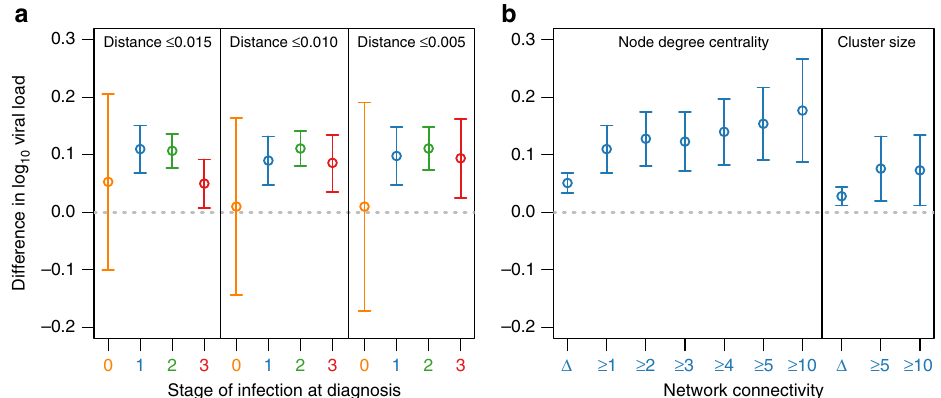
Fig. 2 Increase in viral load for clustered versus nonclustered individuals. a Betas from the multivariate regression model for the difference in log 10 viral load (copies/ml) in clustered individuals versus nonclustered at different stages of infection at diagnosis and different genetic distance thresholds: ≤ 0.015 substitutions/site, ≤ 0.010 substitutions/site, and ≤ 0.005 substitutions/site. Stage of infection is denoted by color. b Betas from the multivariate regression model for difference in log 10 viral load for individuals diagnosed at stage 1 infection with increasing node degree centrality (i.e., number of genetically linked partners) and cluster size relative to nonclustered individuals. Error bars represent the 95% con fi dence intervals for these estimates of beta. Node degree centrality compares individuals with at least that degree versus nonclustered individuals. Hence, node degree ≥ 1 in b is equivalent to clustered versus nonclustered depicted in a . Cluster size compares individuals in clusters of at least that size versus individuals in clusters of small sizes (i.e., cluster size ≥ 5 versus cluster size <5). Δ denotes the difference in log 10 viral load for each increase in node degree centrality or cluster size. Network constructed at ≤ 0.015 substitutions/site. Sample sizes ( n ) for statistical tests are provided in Table